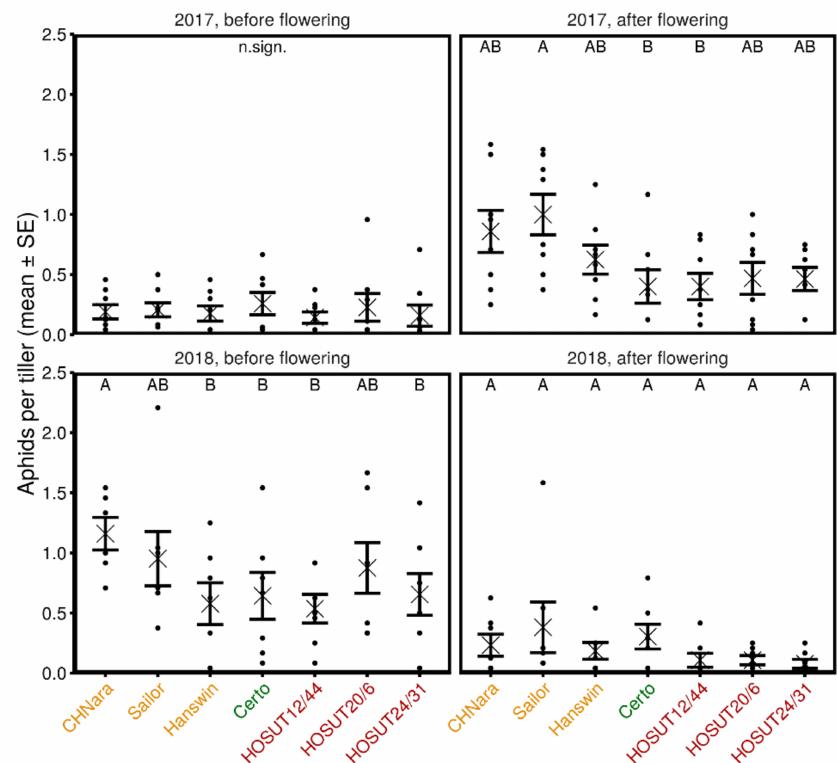
Figure 2. Population size of all aphids recorded on di ff erent wheat entries in the field before and after flowering in 2017 and 2018 (Zurich, Switzerland). The field experiment was a randomized block design with 7.5 m (2017) or 7.4 m (2018) × 1.5 m plots and 7 (2018) or 8 (2017) plots (N) per wheat entry. Data were analyzed with linear mixed e ff ects models, fixed factor wheat entry, random factor team member visually counting the aphids. “n.sign.” was used when the model was not significant. Di ff erent letters indicate statistical di ff erences (Tukey HSD test). Dots represent data from individual plots, X-symbols indicate the mean with standard